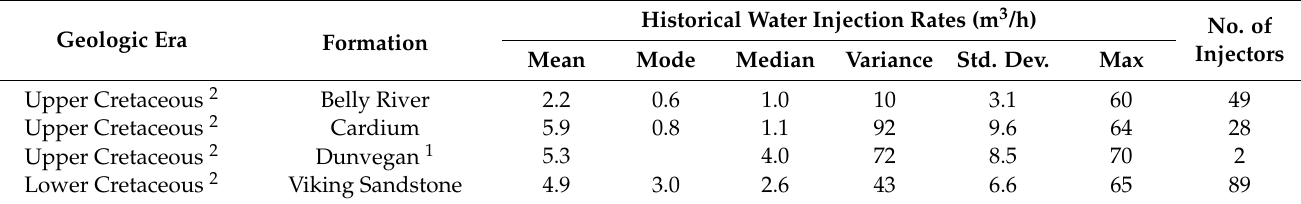
Table 6. Historical water injection rates and key statistical parameters for water disposal